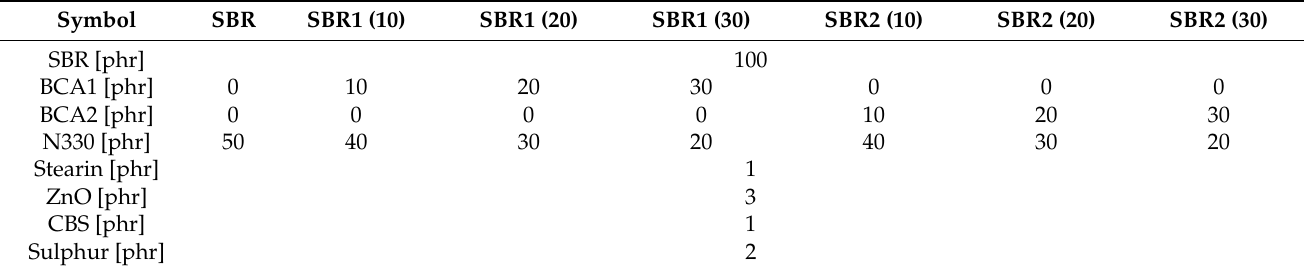
Table 1. Compositions of the elastomer